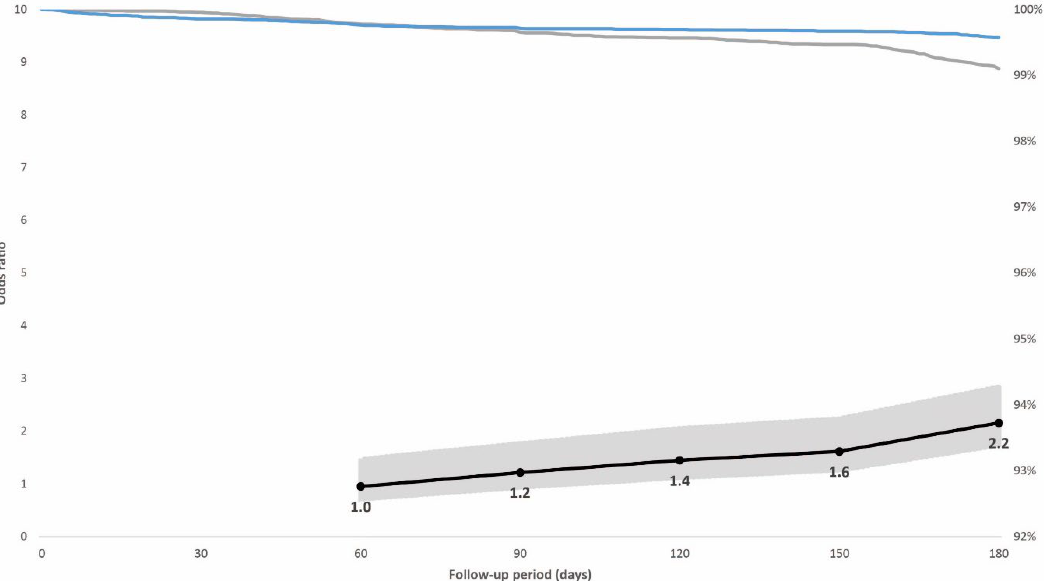
Figure 2. Individuals in the case-control population vaccinated in the prioritized first phase. Right vertical axis: distribution of breakthrough infections in the 180-day follow-up period displayed by immunity status at baseline (blue line: hybrid immunity, grey line: vaccination only). Left vertical axis: odds ratios (black line) including 95% confidence intervals (grey-shaded area) for breakthrough infections adjusted for booster dose administration among individuals with vaccination alone compared with individuals with hybrid immunity for post-vaccination days 60, 90, 120, 150, and 180. The initial variants of concern (Alpha and Delta) dominated SARS-CoV-2 circulation during the post-vaccination follow-up period.